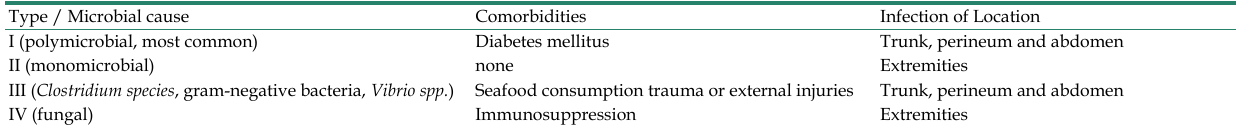
Table 2. Classification system of NF (modified according to Misiakos et al. (2014)).